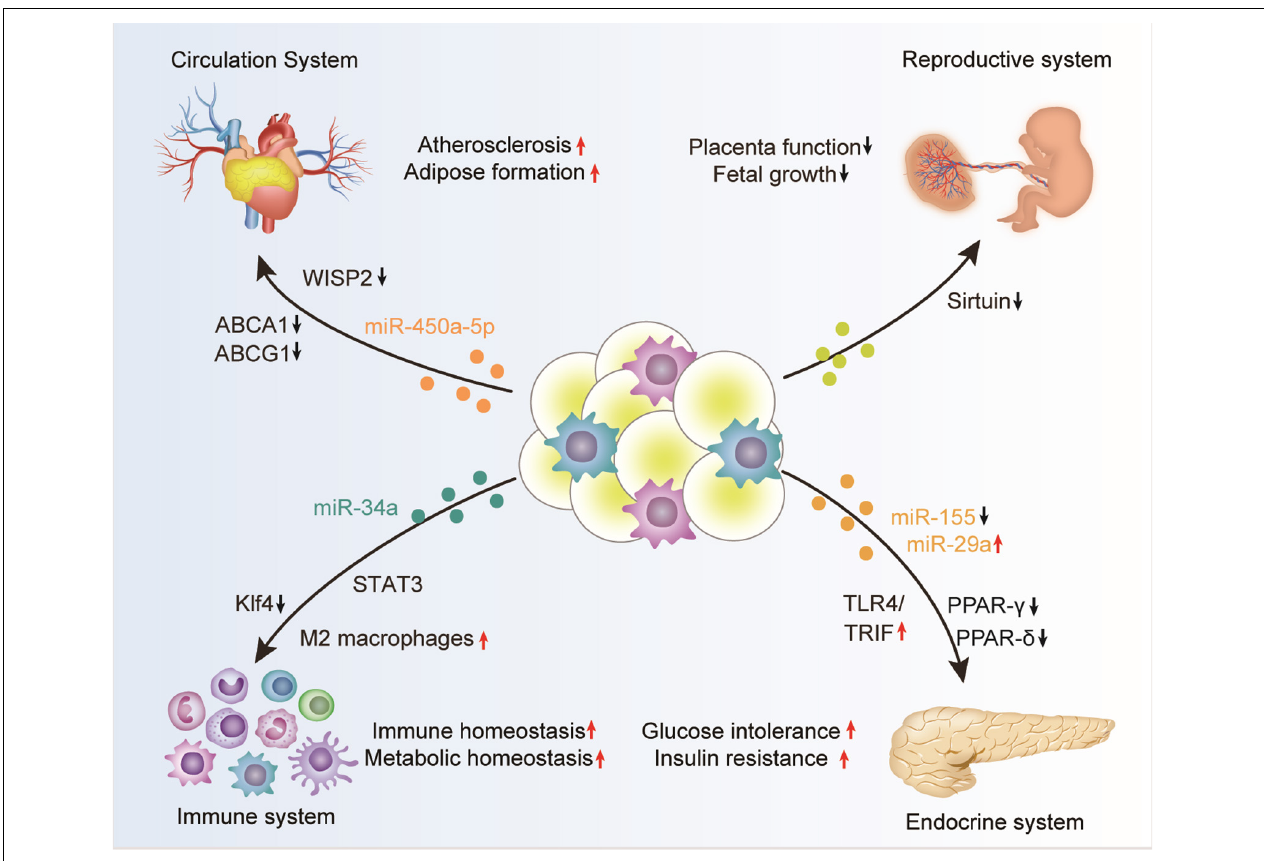
FIGURE 2 | Adipose tissue-derived exosomes in the regulation of biological processes. Adipose tissue derived exosomes, either from the adipocytes, associated macrophages, or other stromal cells, can circulate into distant organs, such as the cardiovascular system, endocrine system, immune system, and reproductive system, where they can regulate the function of the recipient cells. The exosome-mediated crosstalk between adipose and other organs function importantly in many physiological and pathological contexts, especially